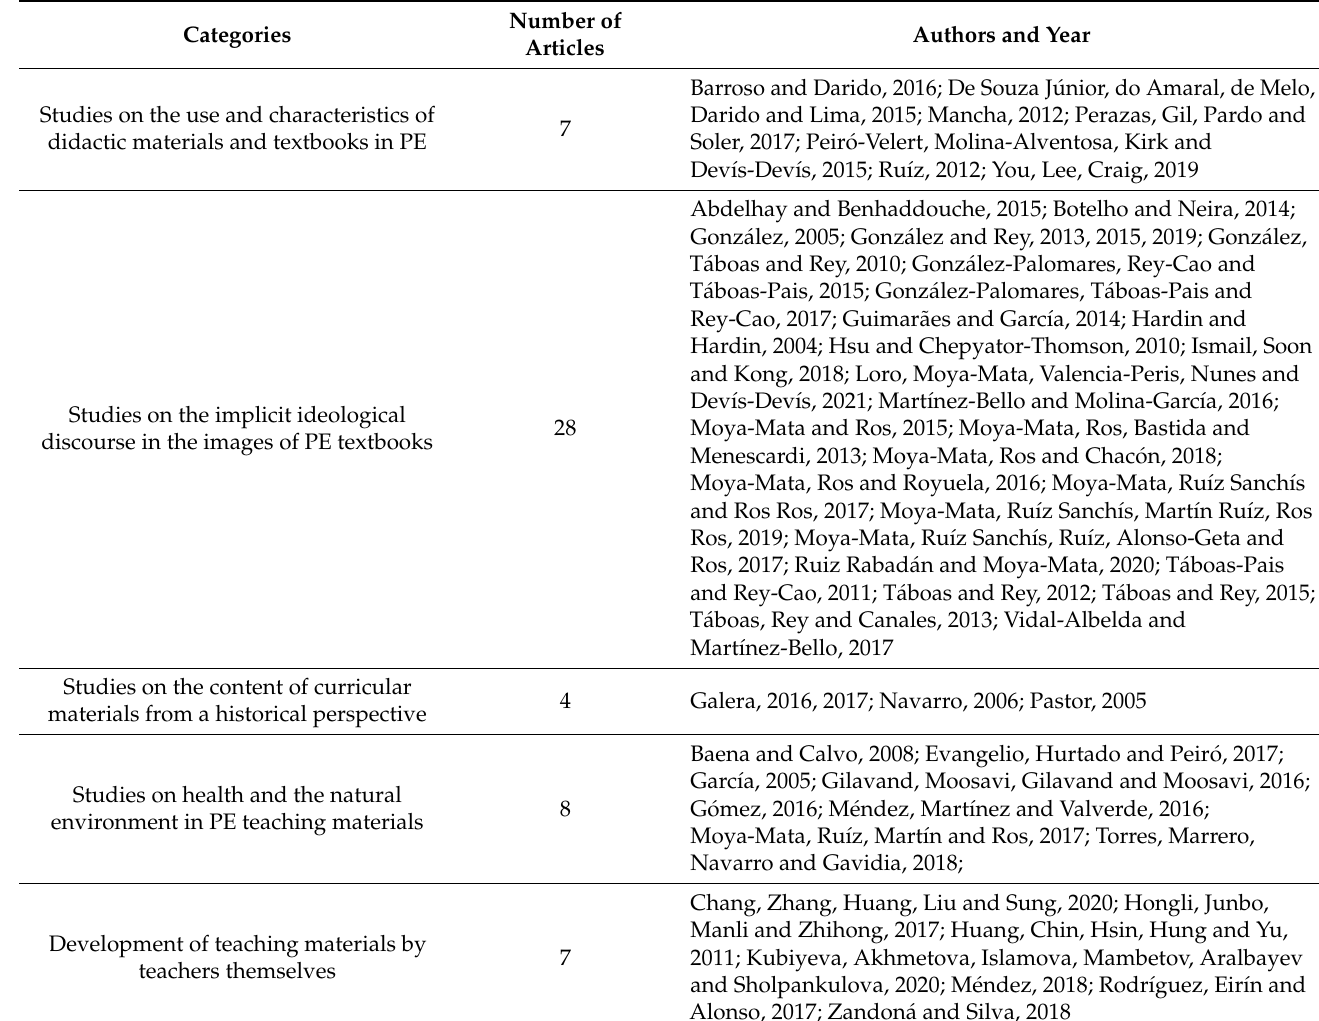
Table 2. Summary of the studies found on textbooks and learning materials in PE in the International